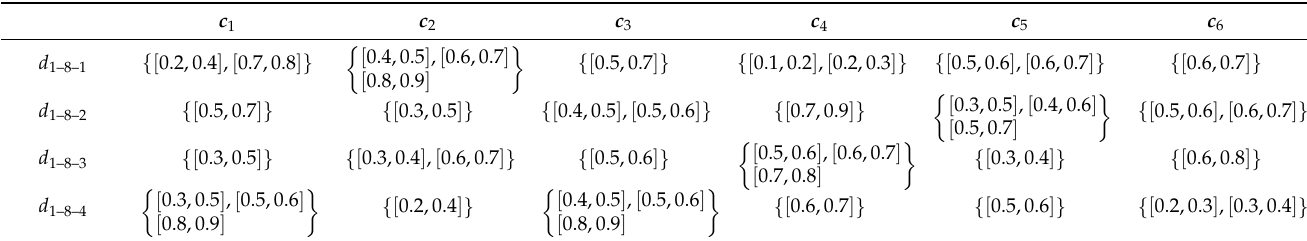
Table A8. Scoring matrix of growth d 1–8